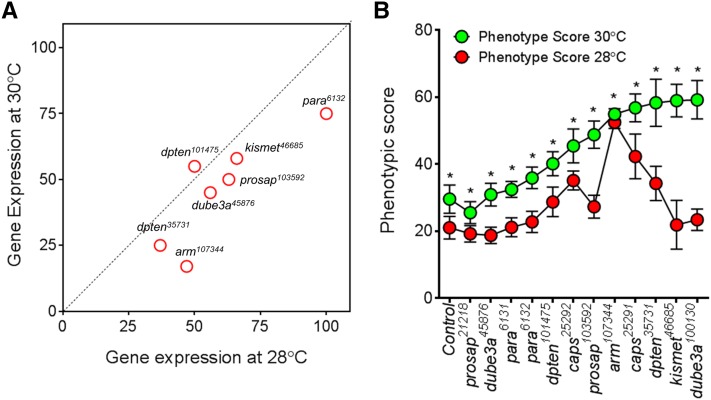
Quantitative assessment of eye phenotypes due to gene-dosage alteration. (A) Plot of mean values of gene expression of RNAi lines with eye specific knockdown at 28° vs. 30°. Note that each experiment was conducted in triplicate, and then repeated using a fresh preparation of RNA and cDNA synthesis. Gene expression of flies reared at 30° is lower than that at 28° due to increased RNAi-mediated knockdown at 30° (note that most red circles are below the black diagonal line), indicating a temperature dependent effect of the UAS-Gal4 system. (B) A graph representing phenotypic scores for knockdown of prosap, dube3a, para, pten, arm, caps, and kismet at 30° and 28° is shown. A dosage dependent increase in severity was observed for all the genes tested. Asterisks (*) show significant P-values (student t-test, corrected two-tailed P < 0.001) when phenotypic scores at 30° was compared to that at 28°. The number of images processed for each genotype ranged from n = 14 to n = 30. A complete list of statistical analysis and n numbers for each of the genotype assessed is presented in Table S6.